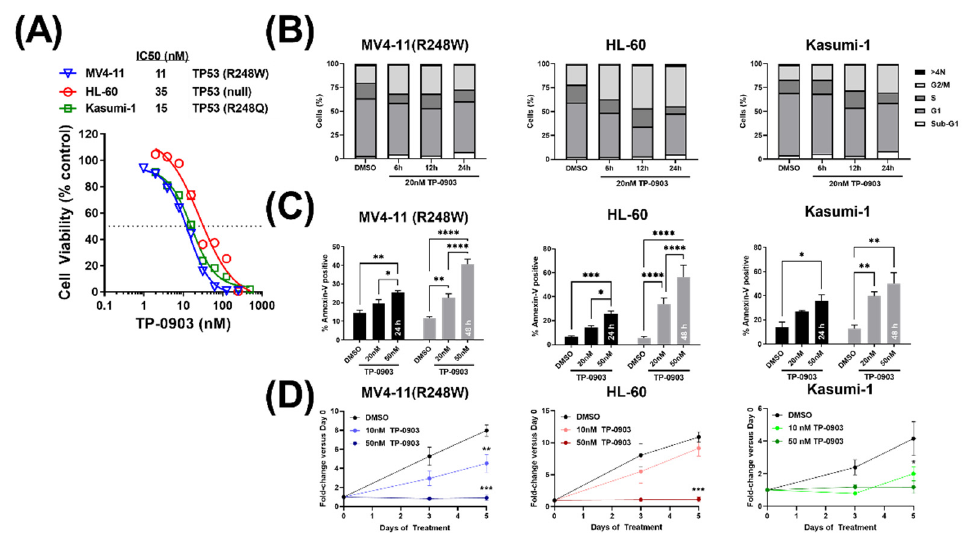
Figure 2. TP-0903 has in vitro activity in TP53 mutant AML cell lines. ( A ) MTT cell viability assay after MV4-11 (R248W), HL-60, and Kasumi-1 cell lines were treated with increasing concentrations of TP-0903 (n = 18 across three independent experiments). ( B ) Cell cycle analysis performed in MV4-11 (R248W), HL-60, and Kasumi-1 cell lines treated with 20 nM TP-0903 determined by flow cytometry using DAPI (n = 4–5). ( C ) Induction of apoptosis in MV4-11 (R248W), HL-60, and Kasumi-1 cell lines treated with TP-0903 (20 nM or 50 nM) for 24 h (black bar) or 48 h (grey bar) determined by flow cytometry using Annexin V (n = 3). Data represent the mean ± SEM. ( D ) MV4-11 (R248W), HL-60, and Kasumi-1 cell lines were plated with increasing concentrations of TP-0903 (10 nM, 50 nM) and counted on days 3 and 5. Cell counts/viability determined by trypan blue exclusion with Nexcelom Cellometer (n = 3). (* p < 0.05, ** p < 0.01, *** p <0.001, **** p <0.0001).